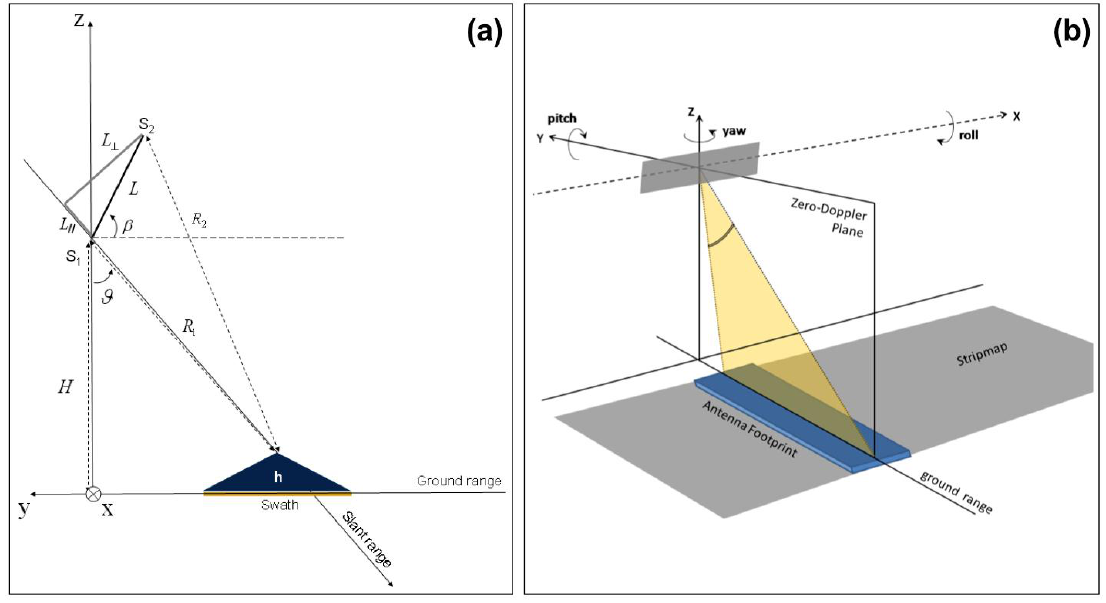
Figure 10. ( a ) InSAR acquisition geometry; ( b ) UAV position (X, Y, Z) and attitude (roll, pitch, yaw) in the basic SAR